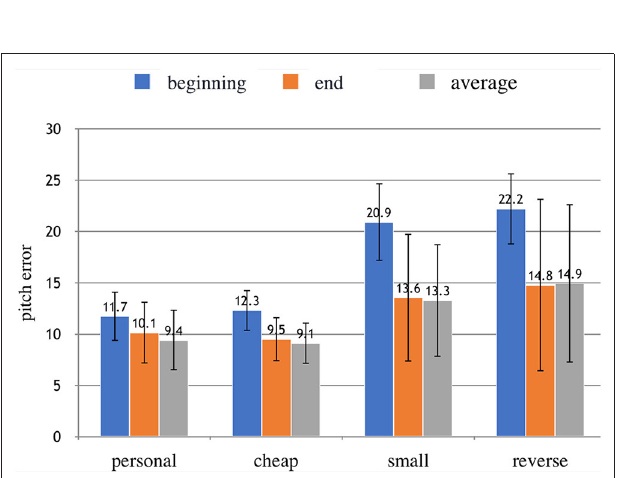
FIGURE 6 | Non-absolute values of the pitch error in the different conditions at the beginning and at the end of each note. The error bars show the StD. A high value above zero means that the note is particularly